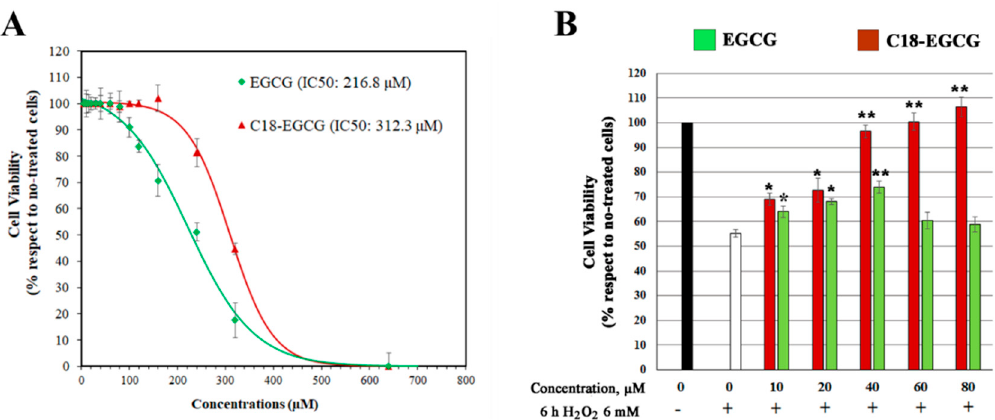
Figure 6. ( a ) IC50 Values for C18-EGCG and EGCG in cytotoxicity assays with retinal cell lines. ARPE-19 cells were treated with 0–640 µ M concentration range of EGCG and C18-EGCG for 48 hours. Cell viability was measured by MTT assay and the values are expressed with respect to cell viability values in untreated cells normalized to 100%. Cytotoxicity curves represent 3 experiments with 5 replicates for each drug concentration. Vertical bars in the graphics represent ± SD. Relative IC50 values shown were determined by non-linear regression using the Sigma Plot Software. ( b ) E ff ect of C18-EGCG in ARPE19 cells after H 2 O 2 exposure. The cells were pre-treated with increasing concentrations of C18-EGCG and EGCG for 24 h, before being exposed to 6 mM H 2 O 2 for 6 h. Cell viability was determined by the MTT assay. Data are reportyed as means ± S.D. of five independent experiments, each performed in triplicate. ** p < 0.001, * p < 0.05 di ff erence from control, representing H 2 O 2 -exposed cells, as reported in the figure.